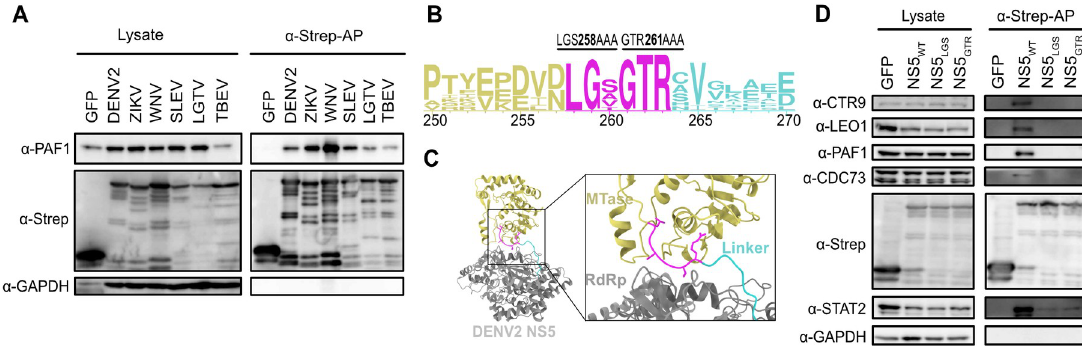
Fig 5. A highly conserved region of the MTase C-terminus is required for PAF1C binding. (A) The protein interaction between flavivirus NS5s and PAF1 was tested biochemically. Plasmids encoding NS5s and GFP were transfected and affinity purified in HEK293T cells via a 2xStrep II tag. Immunoblot analysis of lysate and purified (Strep-AP) fractions were performed against PAF1, Strep, and GAPDH (loading/negative control). (B) Logo analysis of amino acid conservation for flavivirus NS5s from (A) in the PAF1-interacting region. The conserved stretch from amino acids 258–263 (magenta) was targeted for alanine scanning leading to the generation of 2 NS5 mutants: LGS258AAA (NS5 LGS ) and GTR261AAA (NS5 GTR ). (C) DENV2 NS5 structure from PDB (5ZQK) with PAF1-interacting region highlighted (box). The PAF1-interacting region overlaps with the C-terminal end of the MTase (yellow) and the flexible